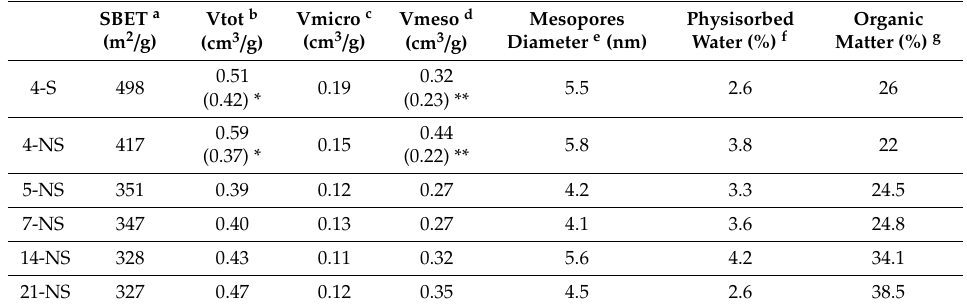
Table 1. Textural properties of the calcined obtained samples and weight losses determined by TGA on as-made samples.